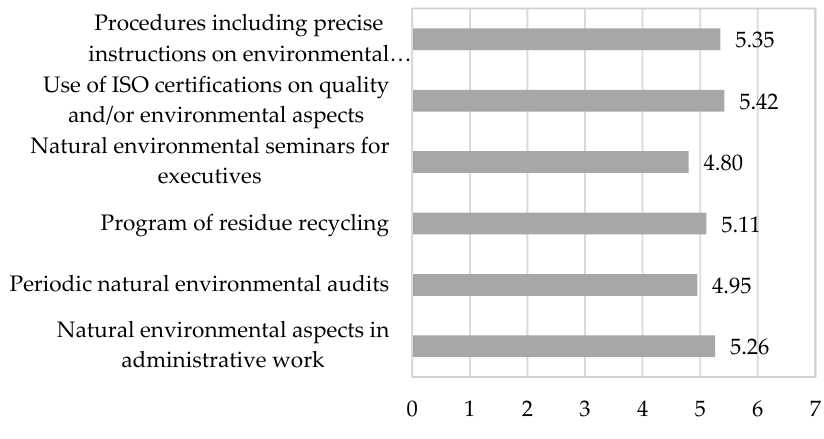
Figure 2. Environmental process innovation.